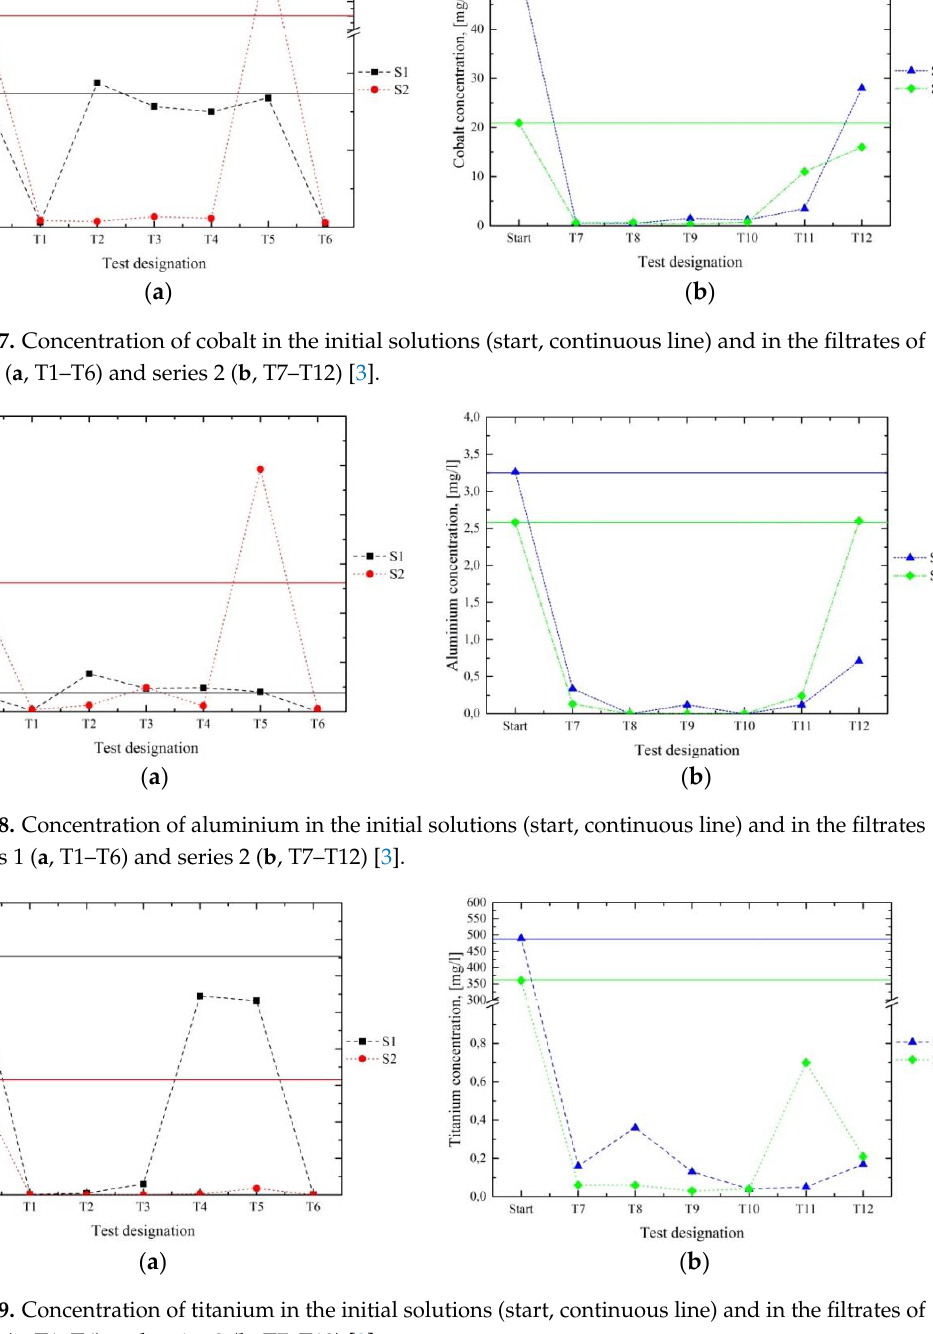
( b ) Figure 10. Concentration of tantalum ( a ) and niobium ( b ) in the initial solutions (start, continuous line) and in the filtrates of series 1 [3]. ( a ) ( b ) Figure 11. Concentration of tungsten in the initial solutions (start, continuous line) and in the filtrates of series 1 ( a , T1 – T6) and series 2 ( b , T7 – T12) [3]. Figures 7 and 8 present the results for the Co and Al contents of the filtrates. In series 1 (a), the best results were achieved in the first and the last tests (T1 and T6) for both S1 and S2. Throughout the further processing of S1 in T2 – T5, hardly any reduction of Co and Al occurred. During the processing of S2 in series 1, most of the Co and Al contents were removed, except for in T5. The results of series 2 (b) show satisfying results in T7 – T10. These results indicated that the separation of Co and